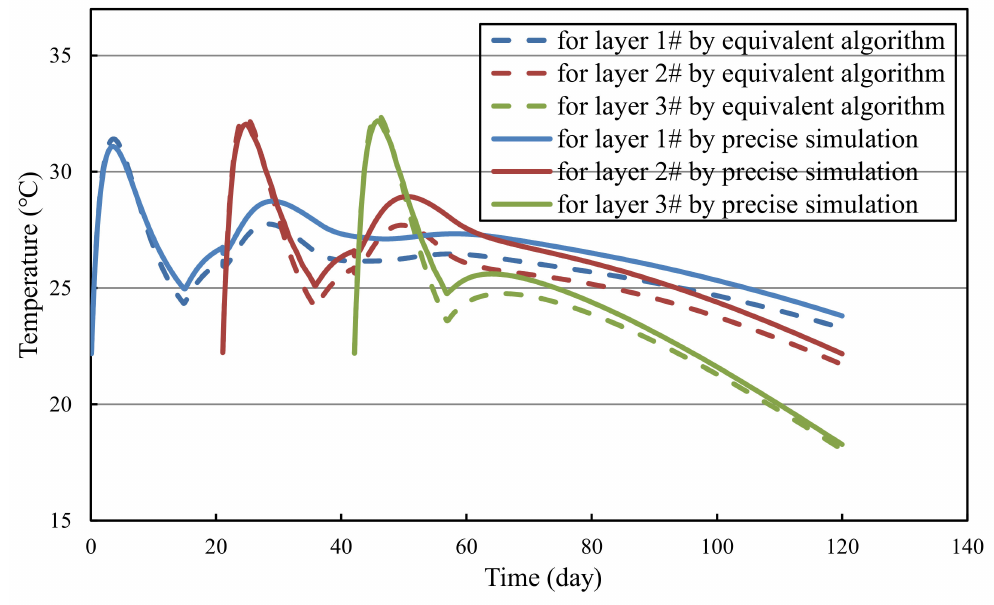
Figure 4. Comparison of calculation results from precise simulation and equivalent algorithm.